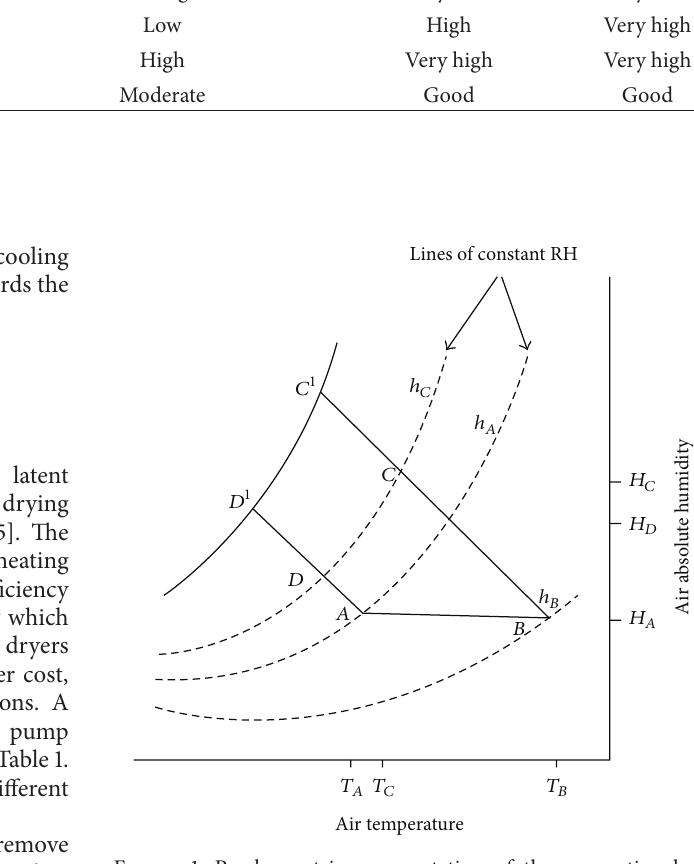
Figure 1: Psychrometric representation of the conventional air drying system. Adapted from FAO